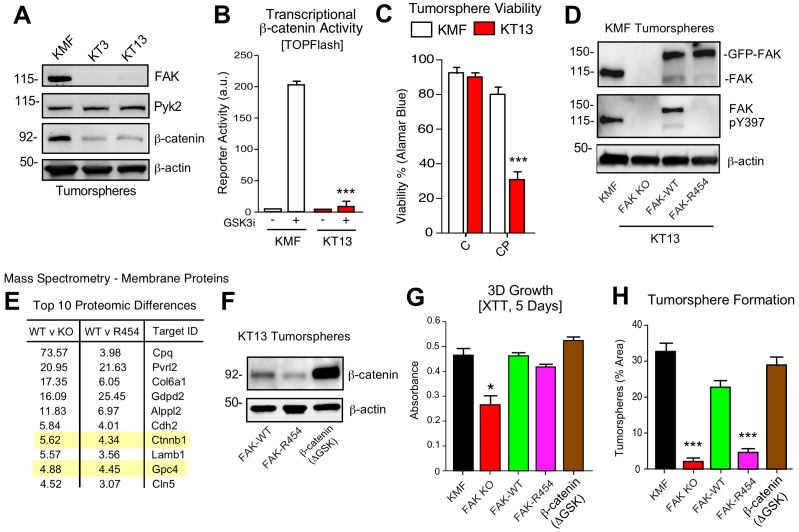
KMF FAK KO and re-expression link intrinsic FAK activity to β-catenin and tumorsphere formation.(A) Immunoblotting of KMF and CRISPR-mediated FAK KO clones KT3 and KT13 cell lysates for FAK, Pyk2, β-catenin, and actin. (B) KMF and FAK KO KT13 cell viability treated with DMSO (control) or CP (1 µM) after 72 hr as measured by Alamar Blue. Values are means (± SEM, *p<0.05, **p<0.01, ***p<0.001, one-way ANOVA with Fisher’s LSD multiple comparison test) for three independent experiments. (C) β-catenin transcriptional reporter activity (TOPFlash) in transfected KMF and KT13 FAK KO cells + /- GSK3β inhibitor. Values are arbitrary units (***p<0.001, unpaired T-test, two independent experiments). (D) Immunoblotting for pY397 FAK, FAK, and actin in lysates of KMF, FAK KO, GFP-FAK-WT, and GFP-FAK-R454 re-expressing cells. (E) Top 10 proteomic differences (fold-change) detected by mass spectroscopy of membrane associated proteins in KT13 FAK KO, GFP-FAK-WT, and GFP-FAK R454 re-expressing cells. (F) Immunoblotting for β-catenin and actin in lysates of KT13 FAK KO cells stably expressing GFP-FAK-WT, GFP-FAK-R454, or β-catenin (ΔGSK). (Gand H) XTT metabolic activity (panel G) or tumorsphere formation (panel H) of KMF, KT13 FAK KO, or the indicated reconstituted cells in PromoCell after 5 days. Values are means (± SEM, *p<0.05, ***p<0.001, one-way ANOVA with a Tukey’s multiple comparisons test) from 2 (panel G) or 3 (panel H) independent experiments.10.7554/eLife.47327.027Figure 8—source data 1.KMF FAK KO clone KT13 exome sequencing variants.10.7554/eLife.47327.028Figure 8—source data 2.Summary of mass spectrometry-detected proteomic changes between KMF FAK KO, FAK-WT, and FAK kinase-inactive (K454R) re-expressing cells grown as tumorspheres.